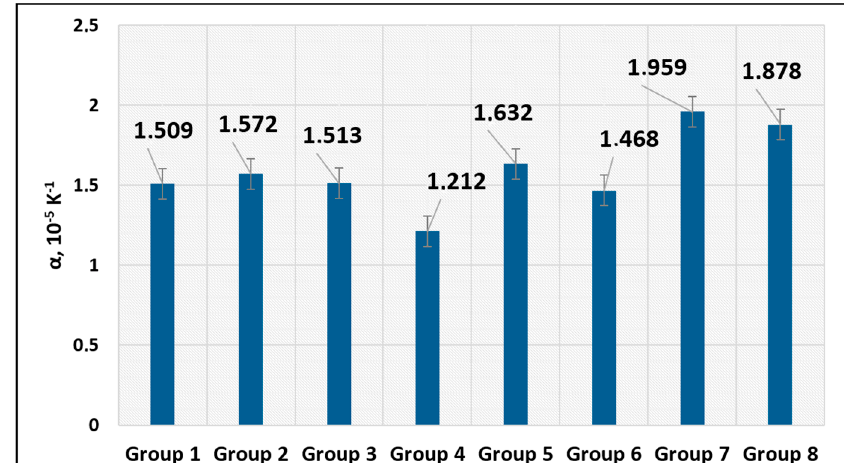
Figure 2. CLTE of Groups 1–8.